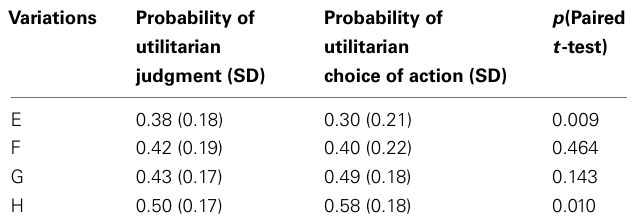
choice judgement